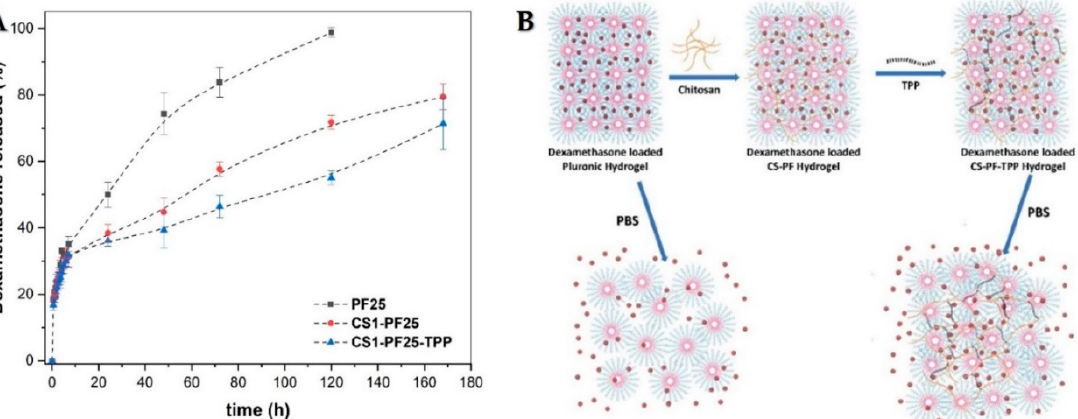
Figure 4. ( A ) Release behavior of dexamethasone from loaded PF25, CS1-PF25, and CS1-PF25-TPP hydrogels. ( B ) Schematic representation of dexamethasone release behavior from CS1-PF25 and CS1-PF25-TPP hydrogels.